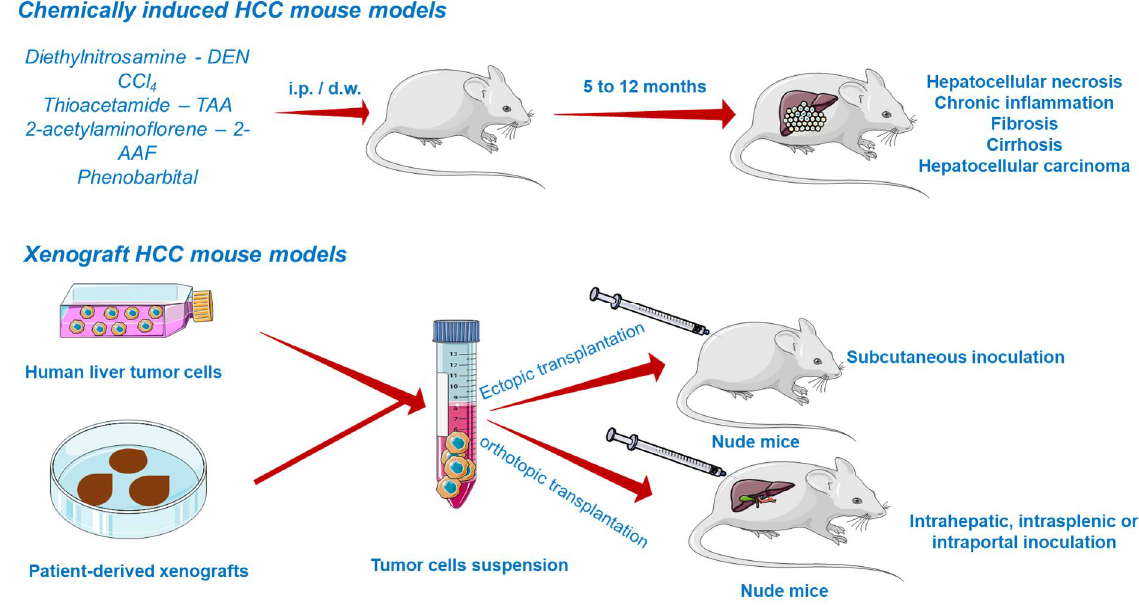
Figure 5. Chemically induced and xenograft mouse models of HCC. This image contains Servier Medical Art elements, which are licensed under a Creative Commons Attribution 3.0 Unported License; https://smart.servier.com, accessed on